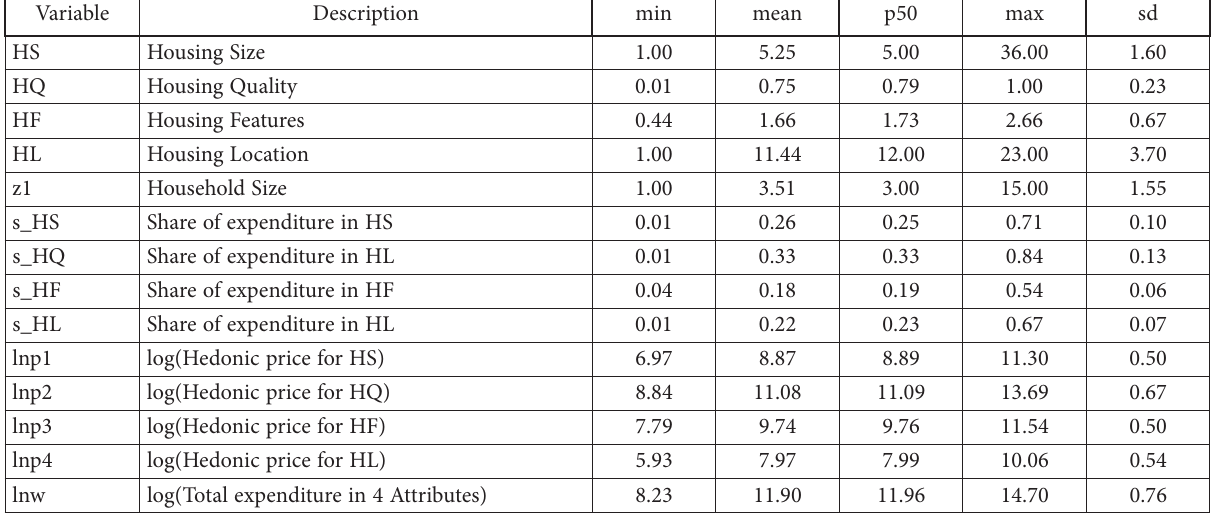
Table 3. Descriptive statistics for Almost Ideal Demand